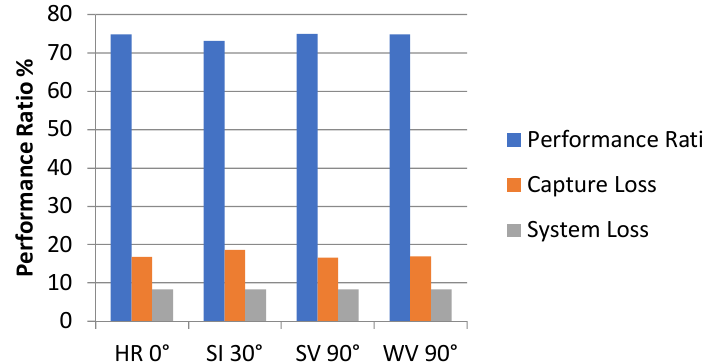
Figure 3. PCS Performance ratio of four different Solar Arrays [22].